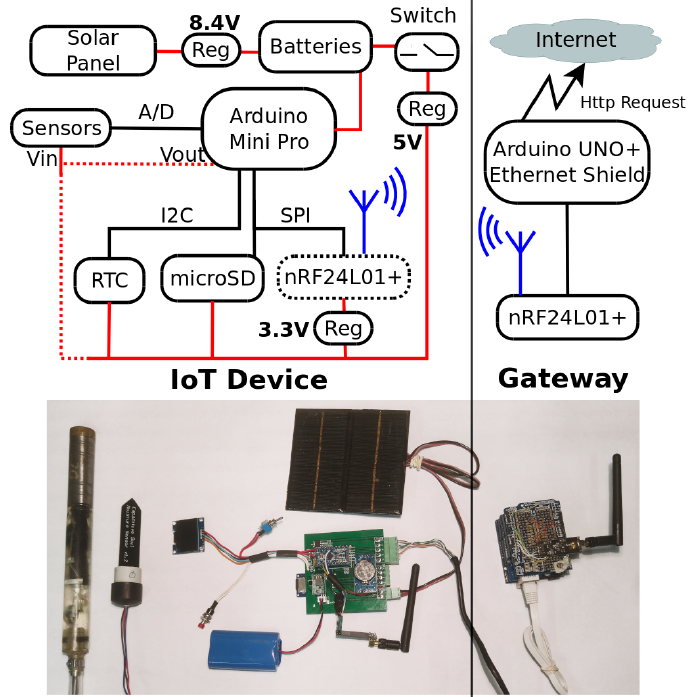
Figure 2. Schematic of the system architecture (Figure A1 of Appendix A contains a diagram of the electronic circuit showing the interconnection between the components of the IoT